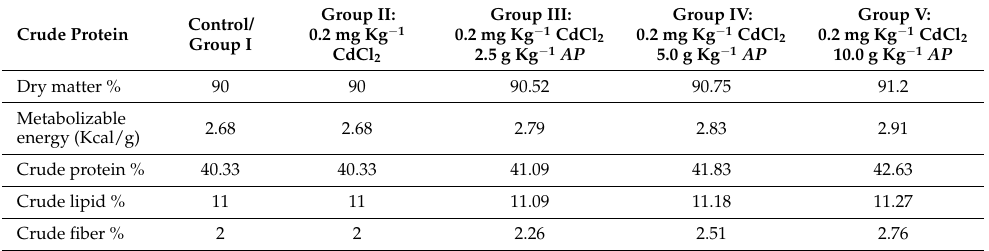
Table 1. A proximate composition of the experimental diets for the rainbow trout. Crude